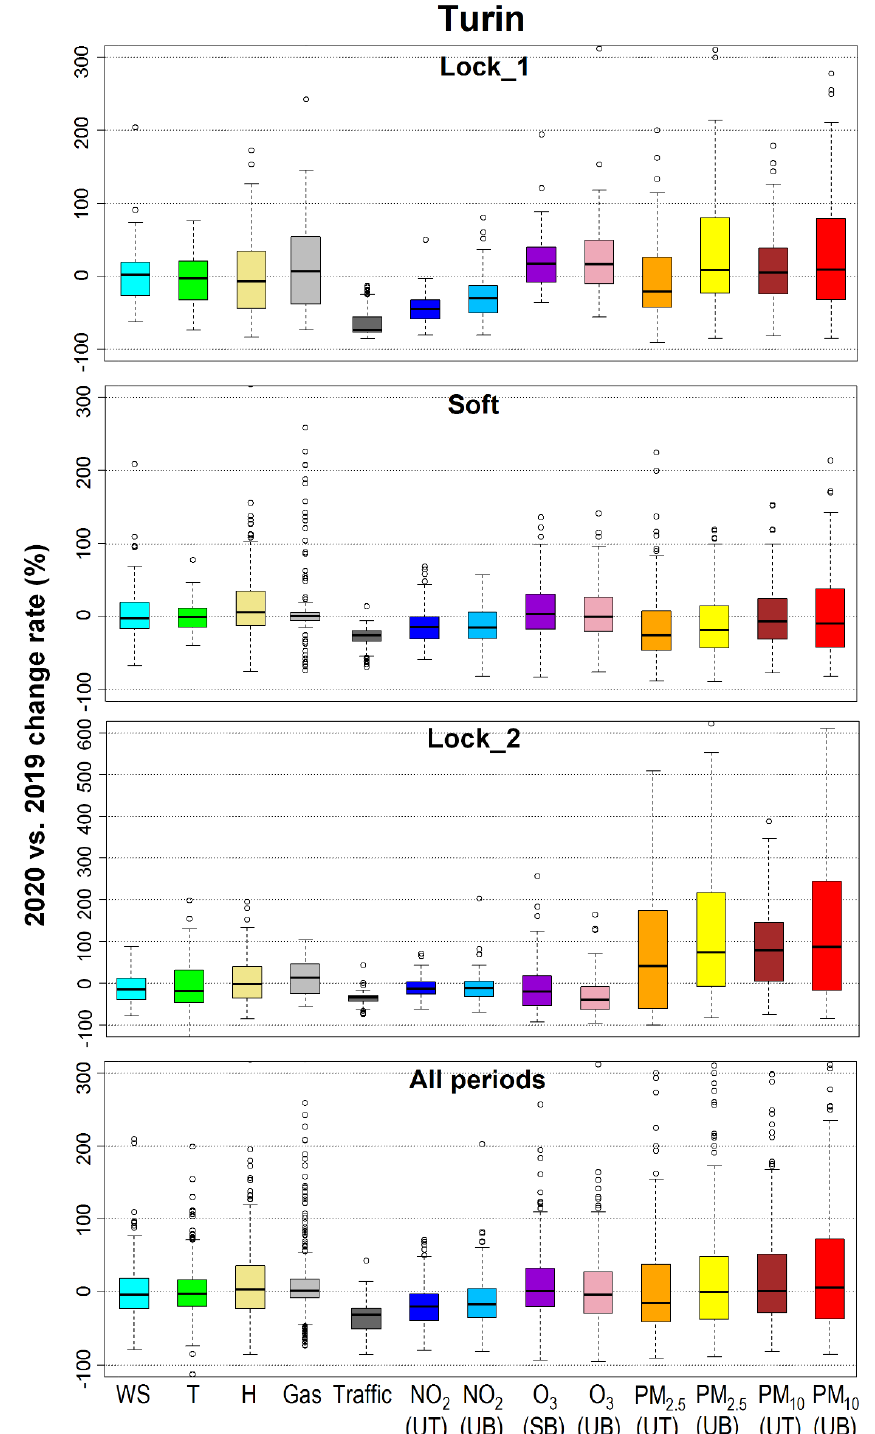
Figure 2. Boxplots by period of 2020 vs. 2019 change rates of daily observations in Turin: concentrations by station type of NO 2 , O 3 , PM 2.5 , and PM 10 ; wind speed ( WS ); air temperature ( T ); PBL height ( H ), gas consumption; road traffic. Boxplots are delimited by the first ( Q 1 ) and third ( Q 3 ) distribution’s quartiles, while the black line inside the box denotes the median value ( Q 2 ). Lower whisker is Q 1 − 1.5*IQR , while upper whisker is Q 3 + 1.5*IQR , where the interquartile range ( IQR ) is Q 3 − Q 1 . Circles outside the whiskers denote outlier data.